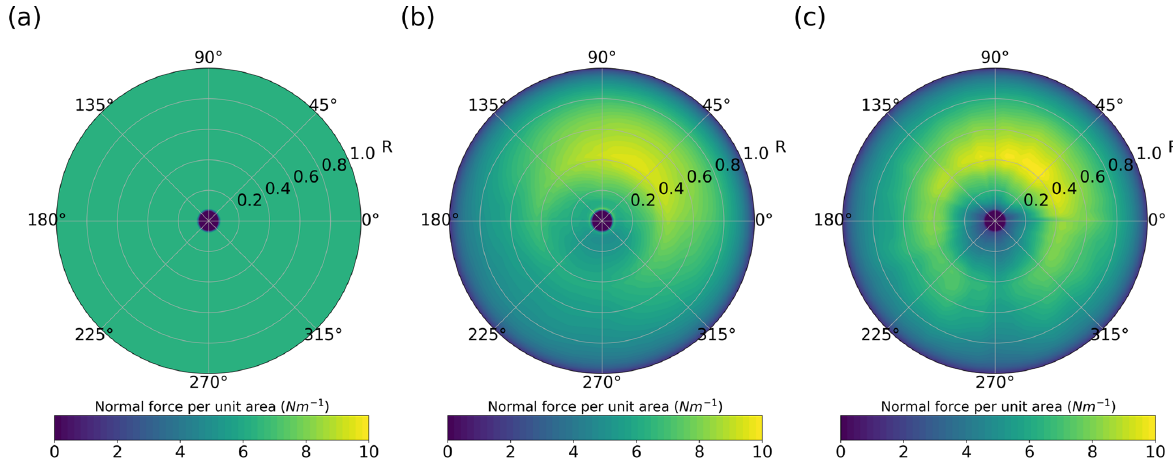
Figure 9. Back-view contours of the time-averaged normal force per unit area on the rotor disk of WT 3 in Case 2. The turbine forces are parametrised by (a) the ADM-std; (b) the ADM-BE; (c) the ALM.